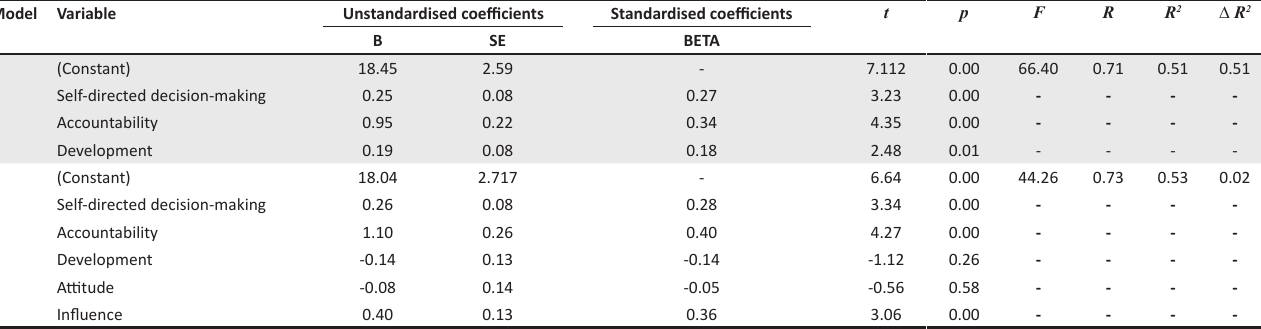
TABLE 6: Multiple regression analysis with participation as dependent variable with leader empowering behaviour and psychological empowerment as independent variables. Model